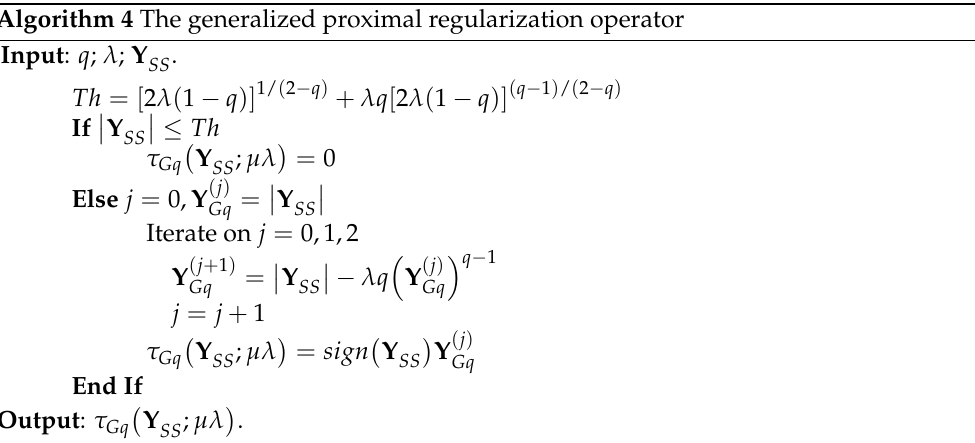
Algorithm 4 The generalized proximal regularization operator